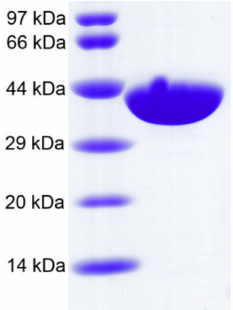
Figure 3. SDS-PAGE analysis of the purified recombinant Ca